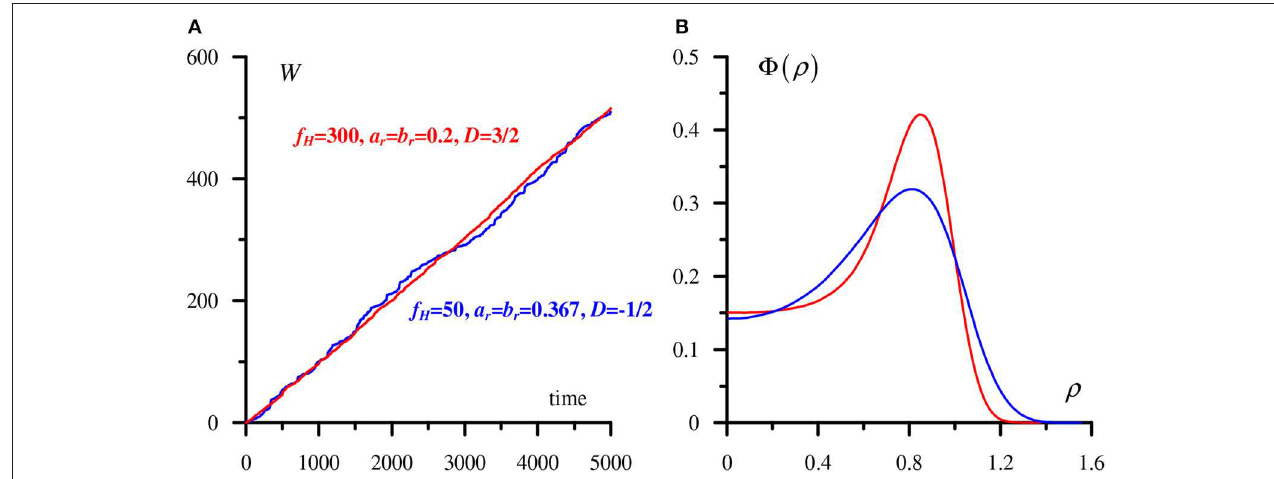
FIGURE 7 | Two total energy dissipation curves can be close once enhanced HF content is compensated for by lowering vibrations amplitude (A) , but the surface energy distributions differ significantly (B) .